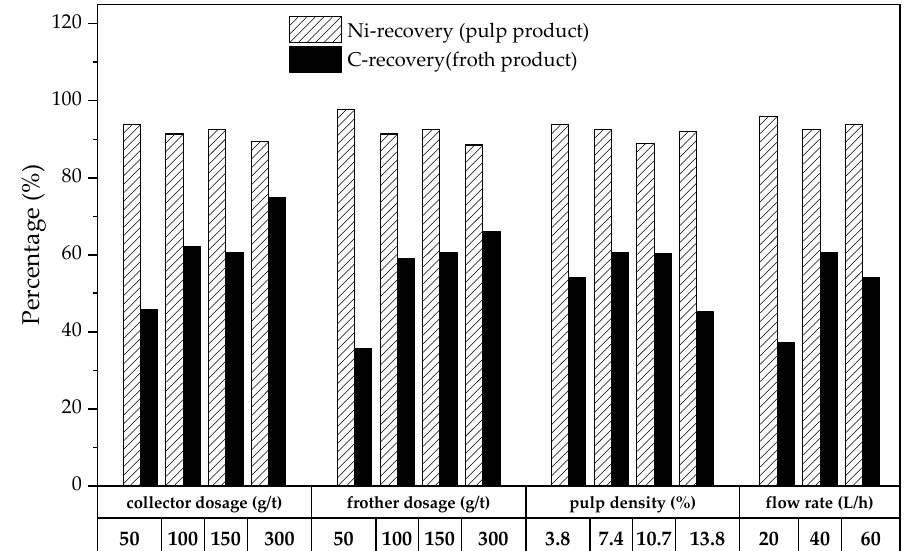
Figure 12. Effects of different flotation parameters on the recovery of flotation products.